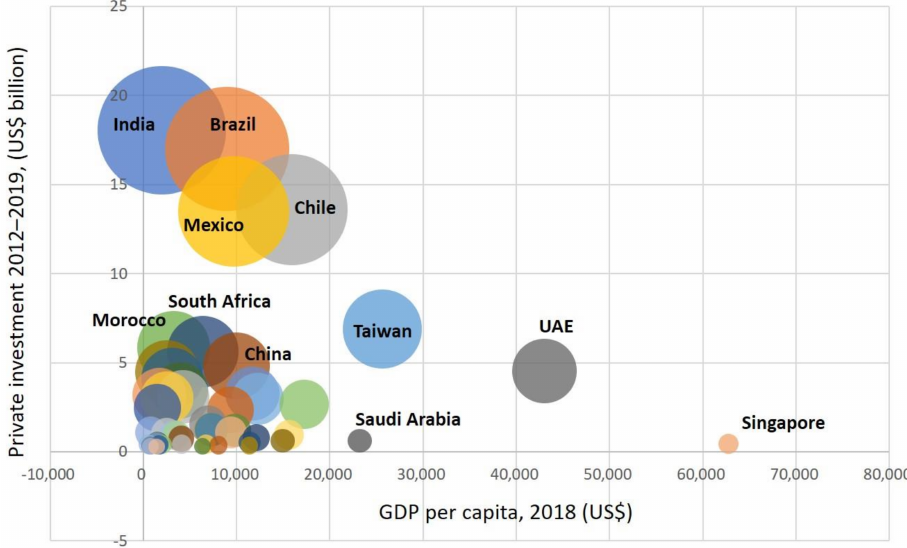
Figure 2. Allocation of cross-border private investment. Source: authors’ illustration based on